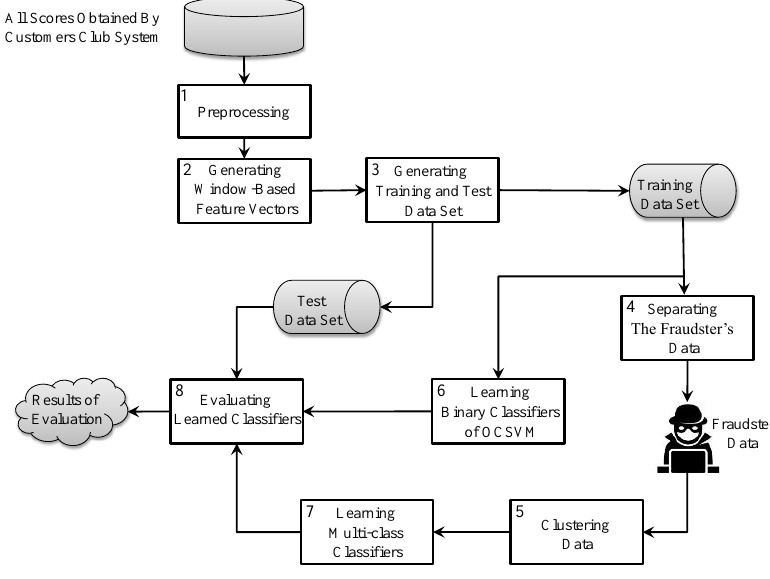
Figure 2. Process of proposed FDiBC method. Table 1. Extracted features for each score obtained by customers.